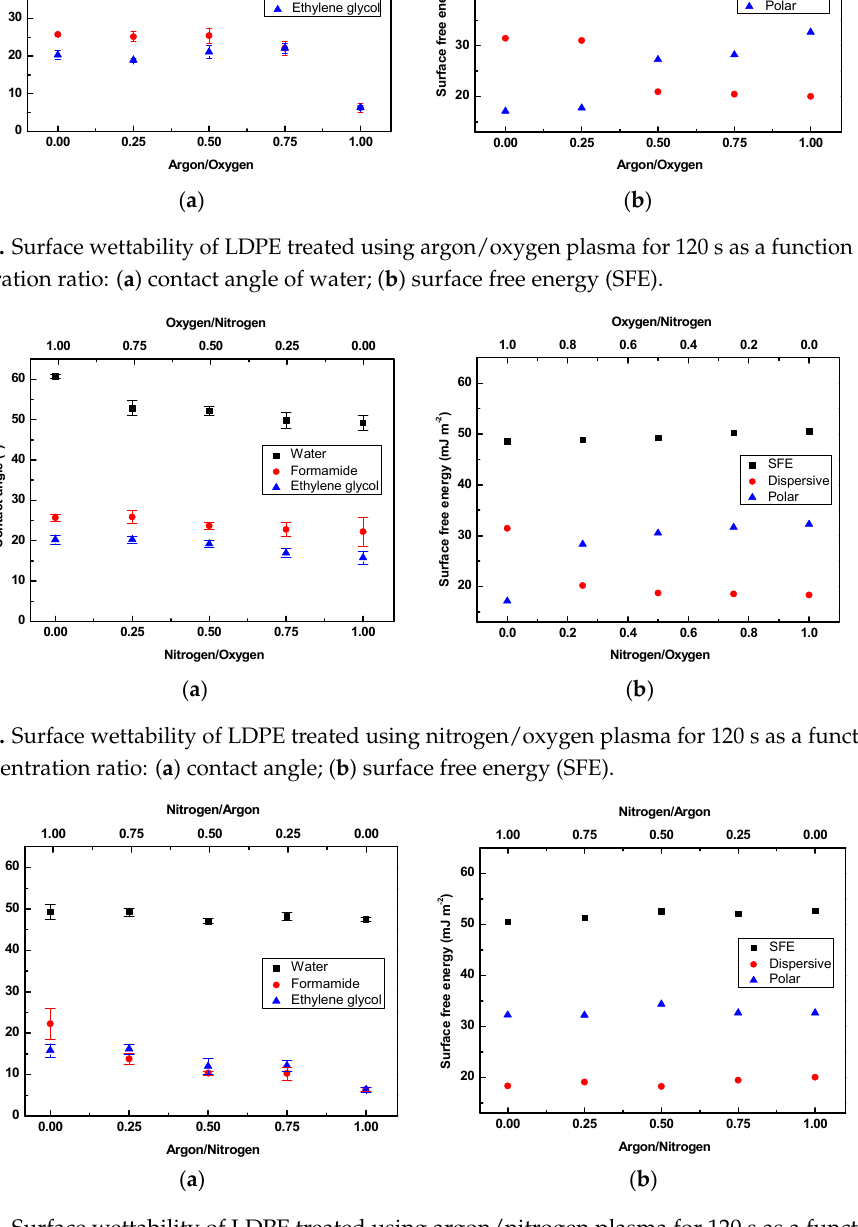
Figure 6. Surface wettability of LDPE treated using argon/nitrogen plasma for 120 s as a function of gas concentration: ( a ) contact angle; ( b ) surface free energy (SFE).